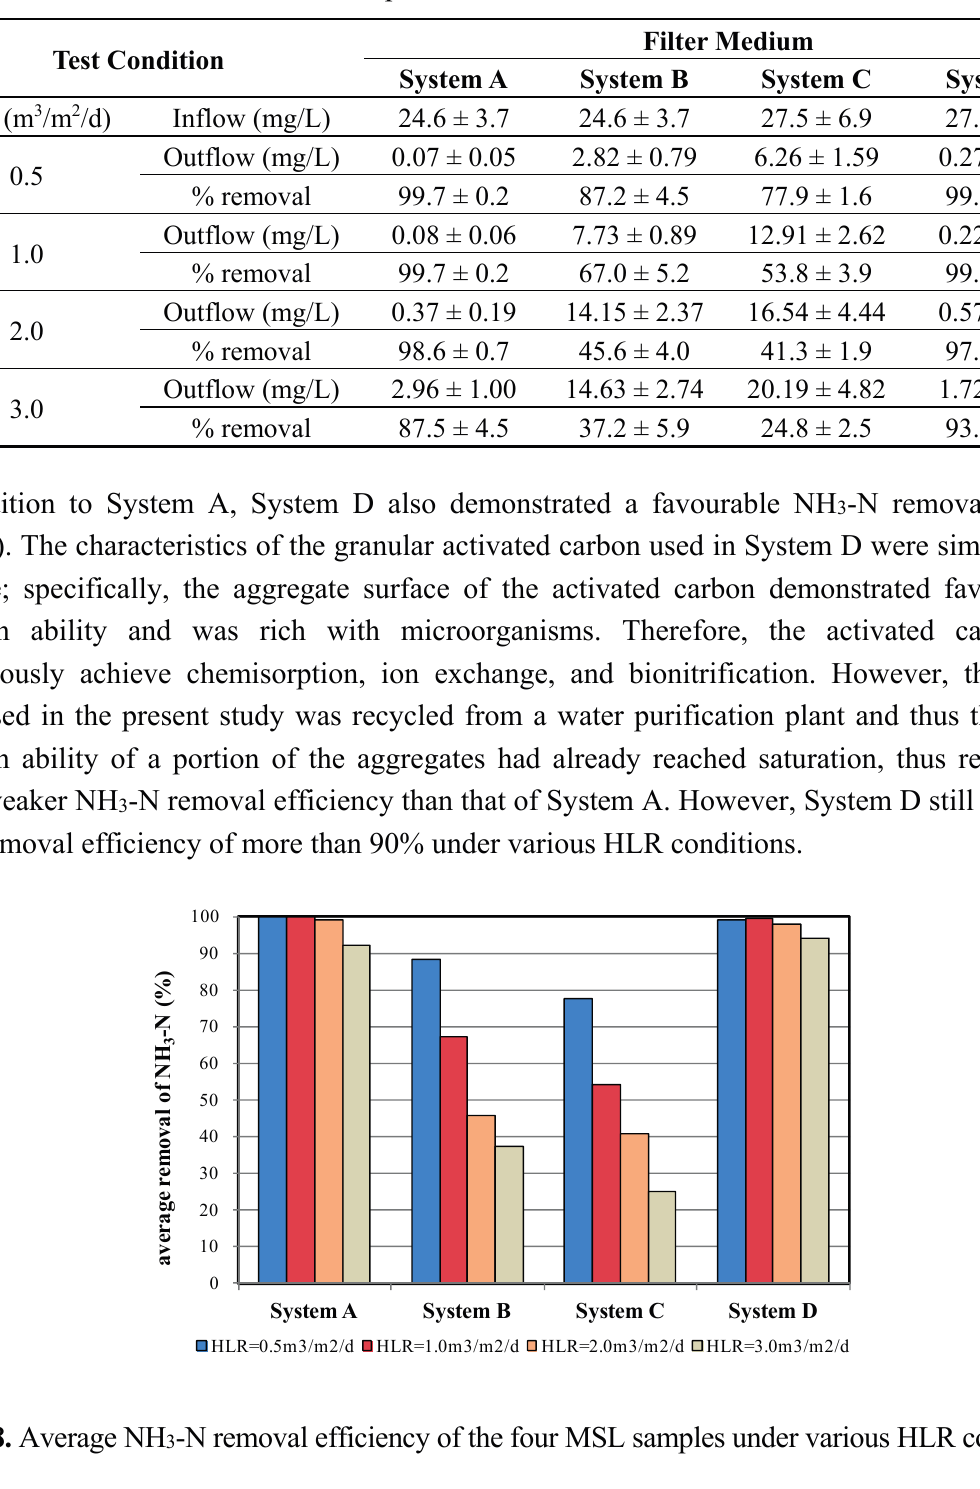
Figure 8. Average NH 3 -N removal efficiency of the four MSL samples under various HLR